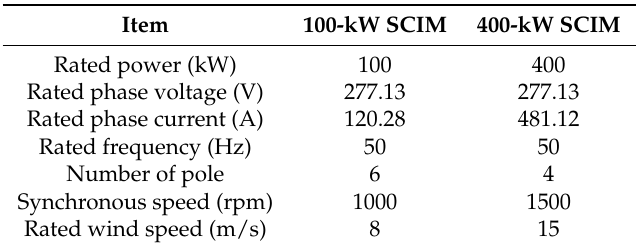
Figure 4. Simulation condition by the wind speed. SCIM, squirrel-cage induction machine. Table 1. Parameters of the squirrel-cage induction machines